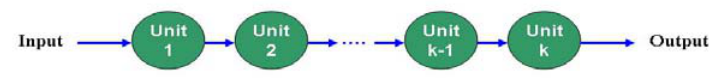
Figure 5. Network elements linked with serial